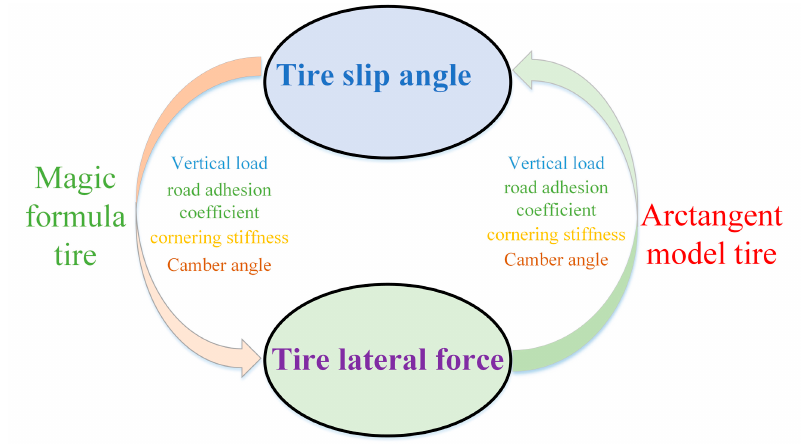
Figure 4. Tire force and slip angle conversion relationship.